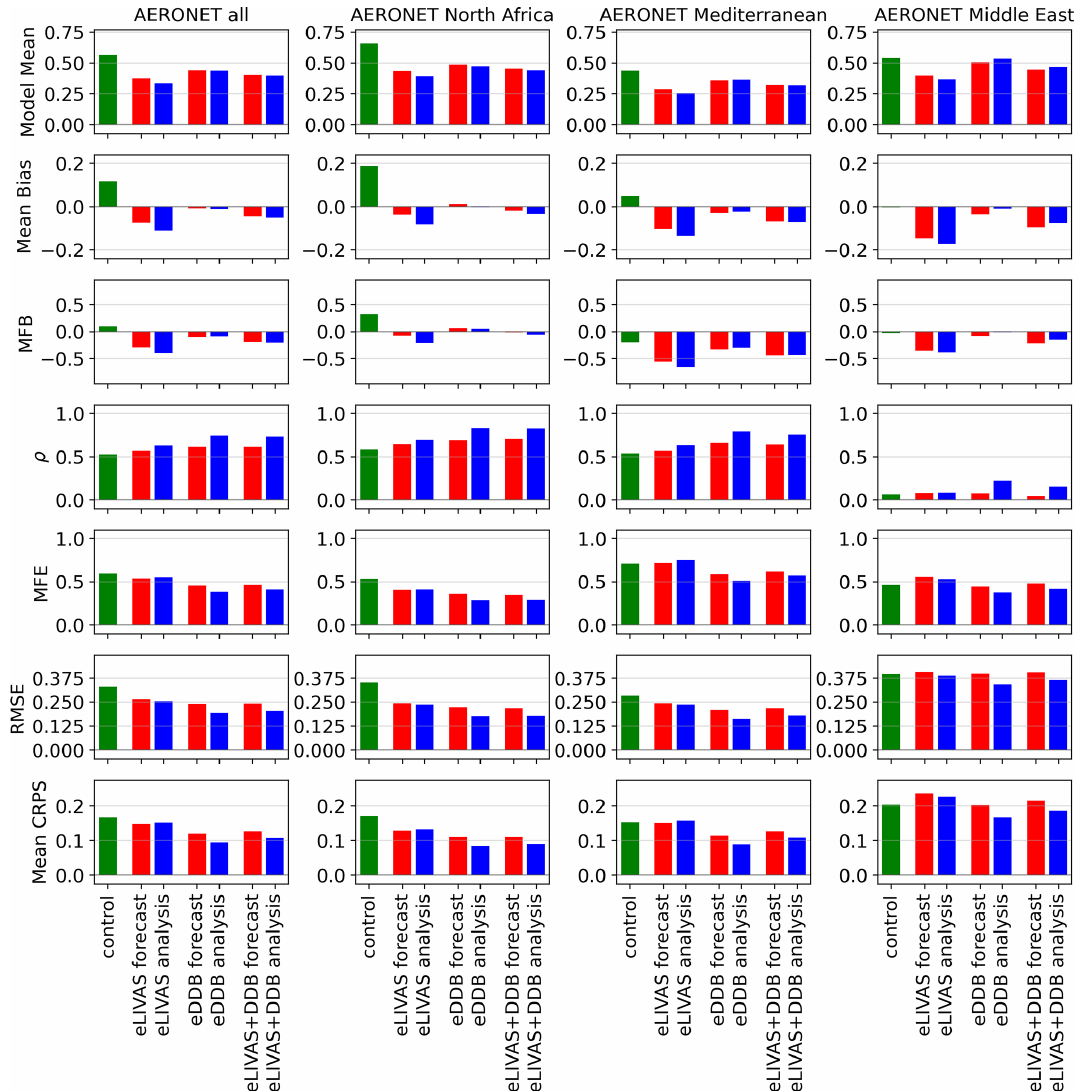
Figure 6. Verification scores against DOD filtered from AERONET AOD